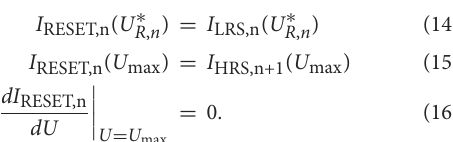
such that their static resistance equals the respective value of R ∗ and R ∗ H , n L , n